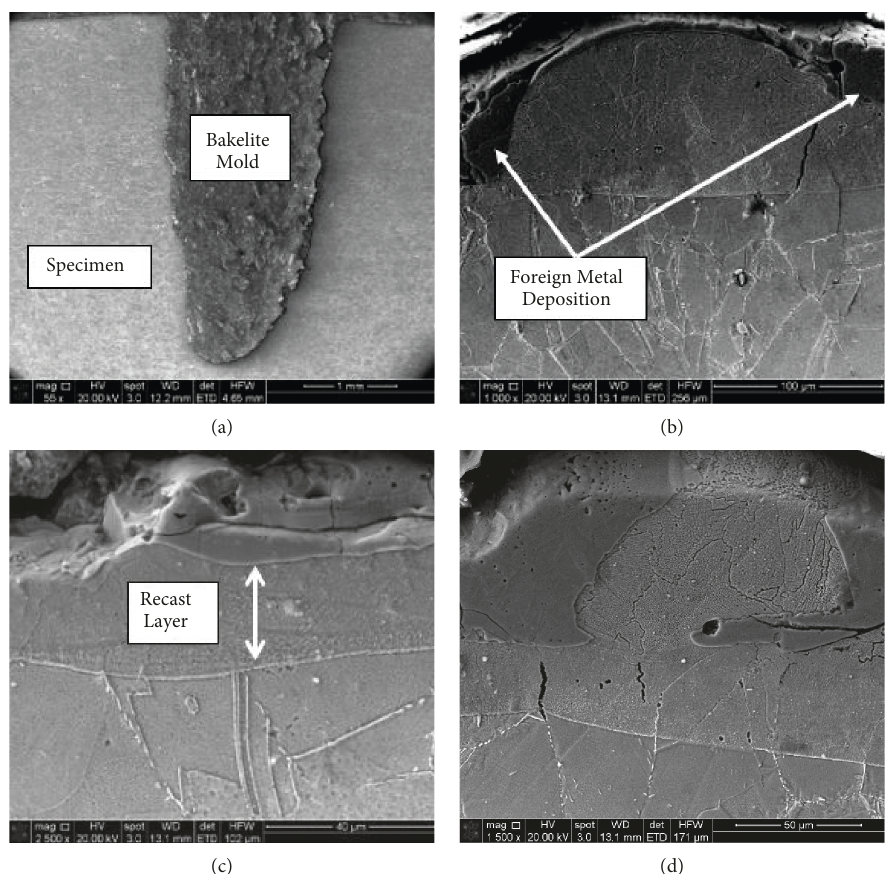
Figure 4: SEM micrographs of electrode wear study for